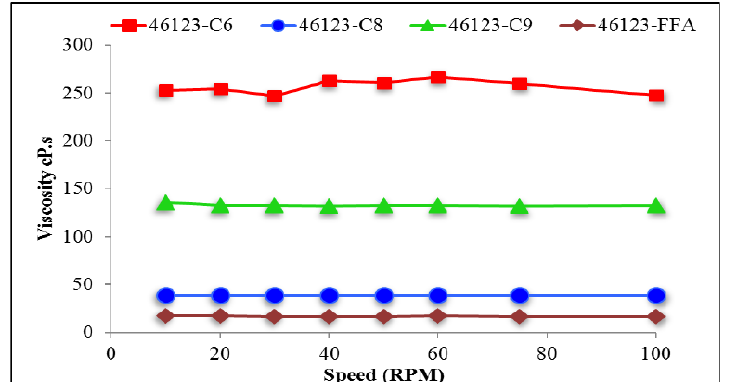
Figure 6. Viscosity of different polymers synthesized by P. putida LS46123 on different substrates. 46123C6, Hexanoic acid; 46123C8, Octanoic acid; 46123C9, Nonanoic acid; and 46123FFA, Biodiesel-derived free fatty acids (REG-FFAs).